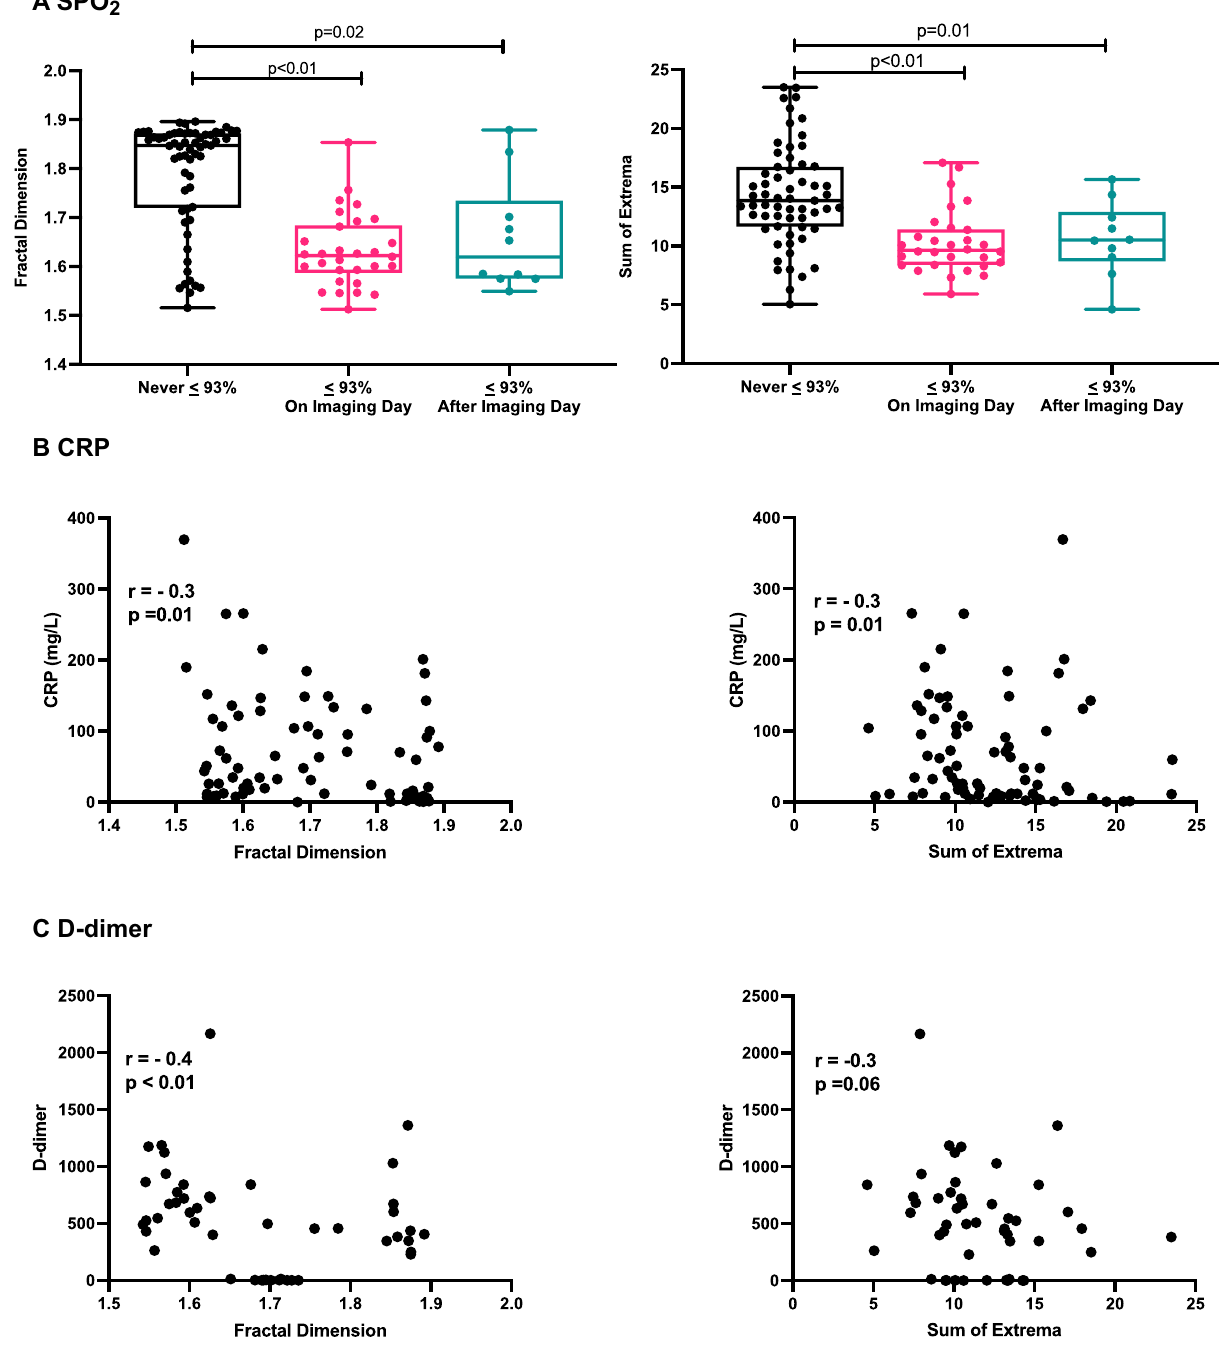
Figure 4. Thermal imaging scores and clinical measurements. ( A ) Box plots with individual measurements of the fractal dimension (FD) (left) and sum of extrema (SX) (right). P value by one-way ANOVA with Tukey’s test for multiple comparisons. ( B ), ( C ) The correlation between the thermal FD and SX scores and C-reactive protein (CRP) ( B ) and D-Dimer ( C ) measured on the day of imaging. P value by Spearman’s correlation